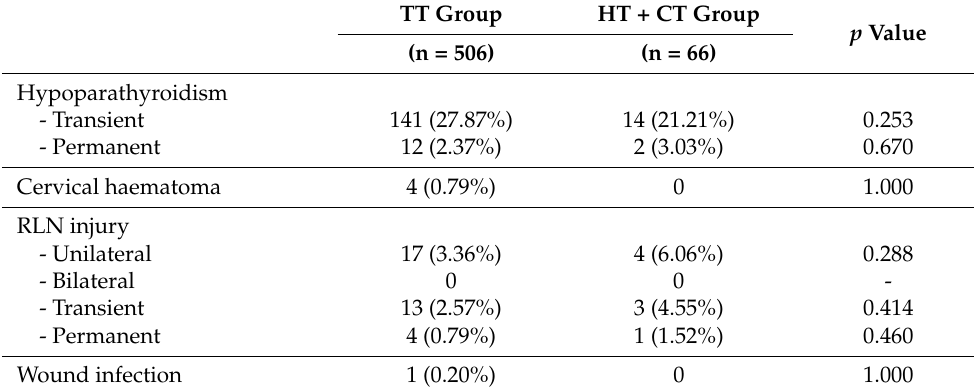
Table 4. Complications in TT Group and HT + CT Group.